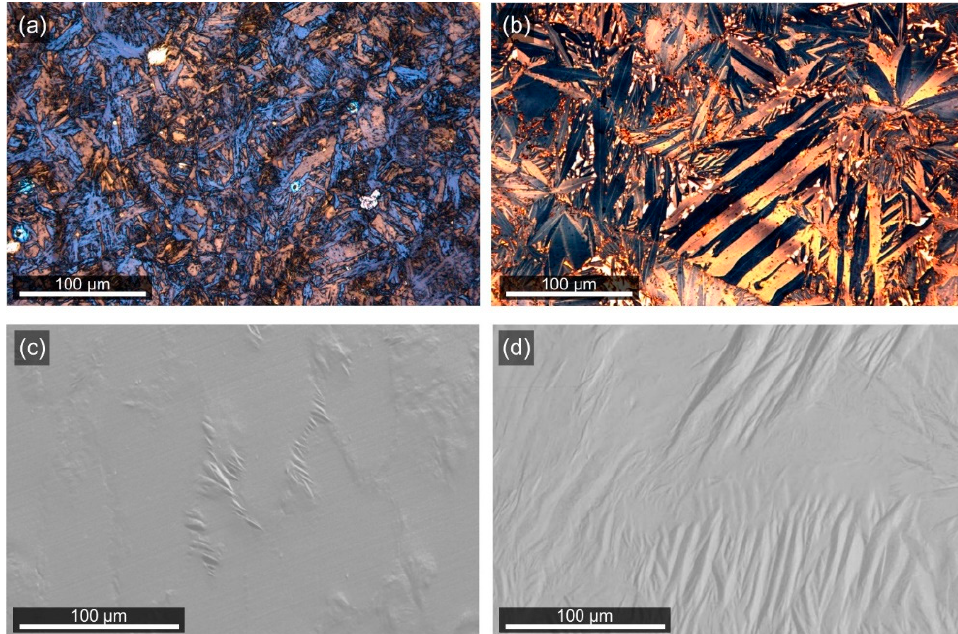
Figure 2. Optical and scanning electron micrographs of martensite surface reliefs. ( a , b ) Optical micrographs (Beraha-II). ( c , d ) SEM micrographs (secondary electron contrast). ( a , c ) Fe-27.5Ni. ( b , d ) Fe-30.0Ni.